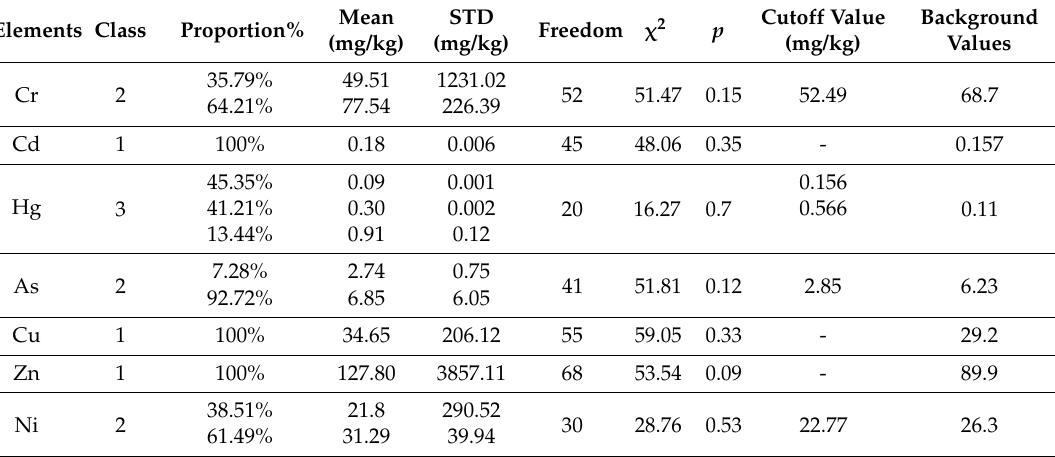
Table 7. FMDM parameters and